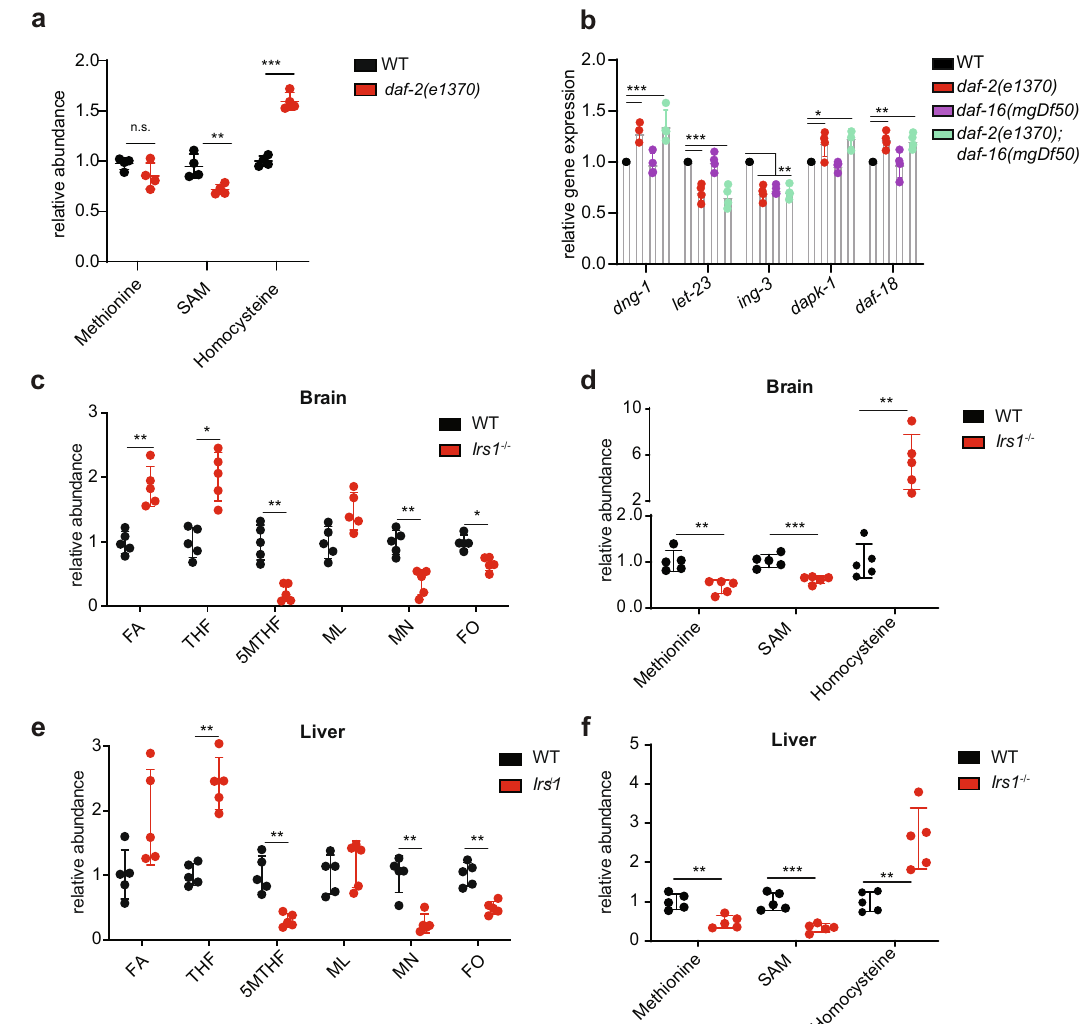
Fig. 5 Reduced insulin/IGF signaling alters folic acid and methionine cycle intermediates. a Relative abundance of methionine cycle intermediates in daf- 2 mutants and WT animals using targeted metabolomics. b Relative mRNA expression level of methionine restriction gene signature in daf-2 and daf-2; daf-16 backgrounds. dgn-1, ing-3, dapk-1, and daf-18 are upregulated and let-23 and ing-3 downregulated in the daf-2 background, independent of daf-16 . c , e Targeted metabolomics of folic acid intermediates in brain and liver in wild-type and Irs1 − / − full body knockout mice. Folic acid and THF increase in Irs1 − / − , whereas 5MTHF decreases in the mutant. d , f Quantitation of methionine cycle intermediates in brain and liver in wild-type and Irs1 − / − knockout mice. Methionine and SAM decrease and homocysteine increases in the mutant. a N = 4 independent biological replicates. b N = 3 independent biological replicates, c – f N = 5 mice, each dot represents a single animal. a – f Signi fi cance was assessed using one-way ANOVA Dunnett ’ s multiple comparisons test. * p < 0.5, ** p < 0.01, *** p < 0.001. Data are presented as mean ± S.D. (Supplementary Table 6 for